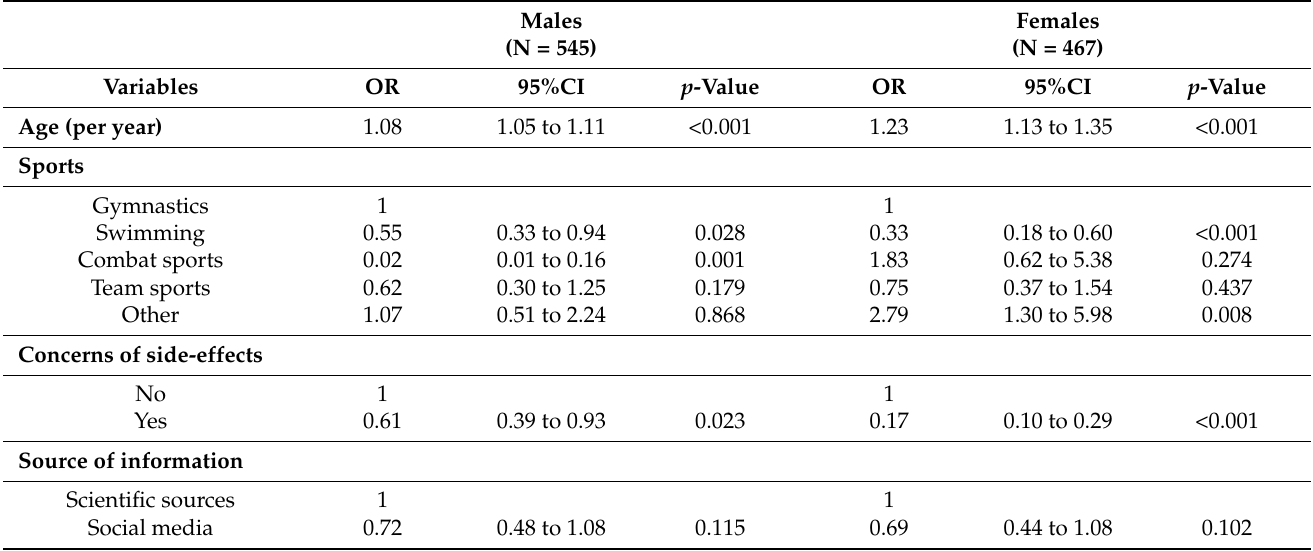
Table 6. Sex-specific odds ratio (OR) and 95% confidence intervals (CI) for getting fully vaccinated versus not getting fully